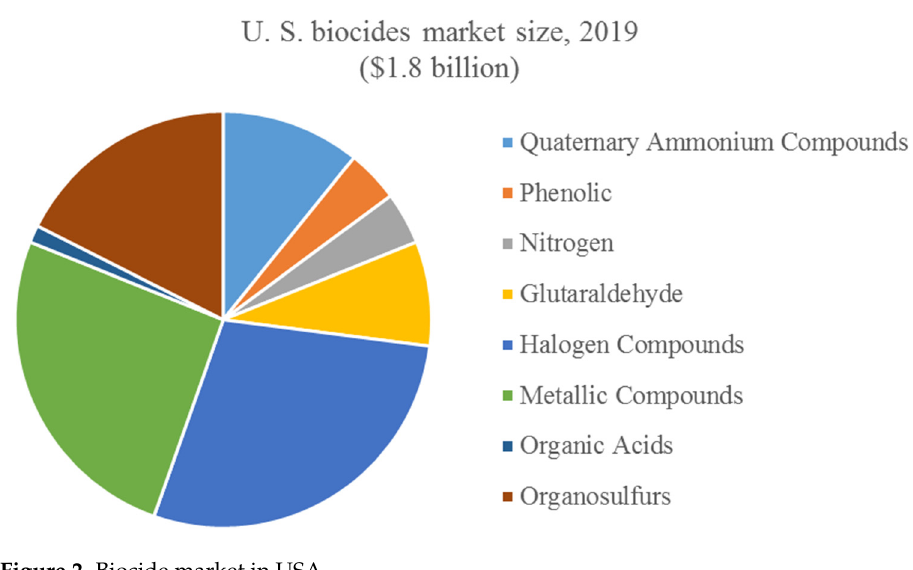
Figure 2. Biocide market in USA.